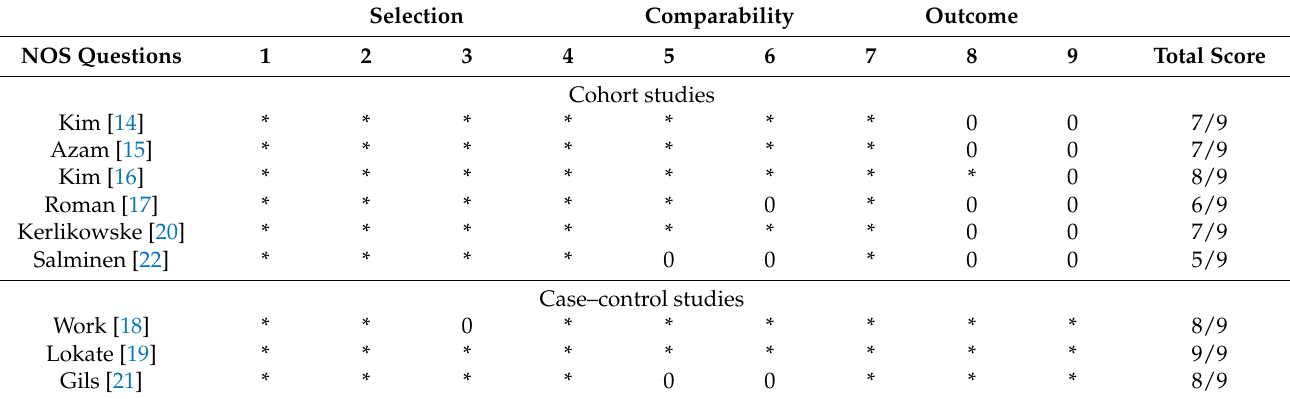
Table 2. Quality assessment of eligible studies. Cohorts and case–control studies presented separately.